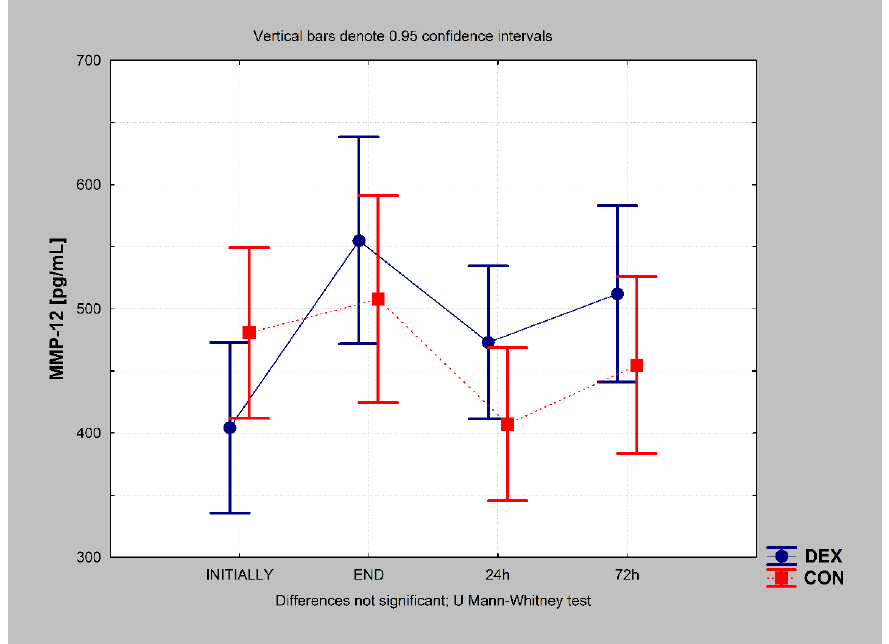
Figure 3. Matrix metalloproteinase-12 (MMP-12) concentrations in the DEX and CON groups at different time points during the study. CON, control; DEX, dexmedetomidine. During the procedure, mean arterial pressure (MAP) was analysed for the following time points: T1, initial; T2, 10 min after intubation; T3, 10 min after ECC institution; T4, 10 min after ECC weaning; and T5, at the end of the procedure. MAP was significantly lower in the DEX group than in the CON group at T3 ( p = 0.031) and T4 (0.003) (Figure 4).